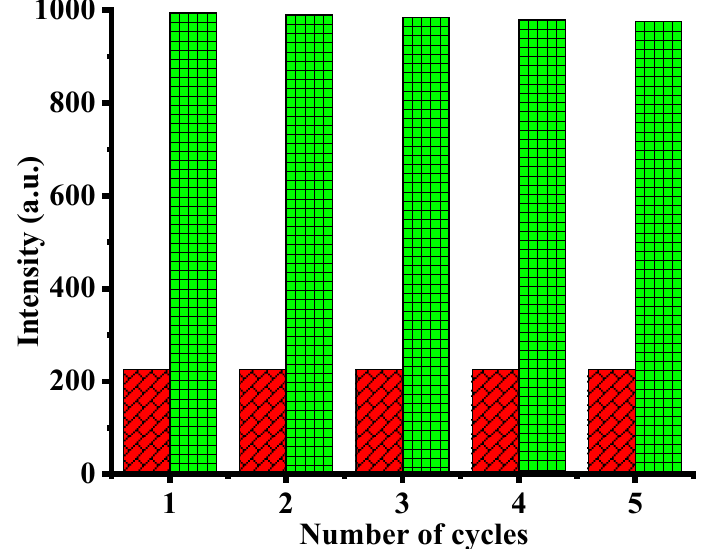
Figure 12. Photoluminescence intensity of 1 in five recyclable experiments for the F − in aqueous solution (The red bar shown the initial fluorescence intensity, the green bar shown the intensity upon addition a distilled water of 1mM F − anion).